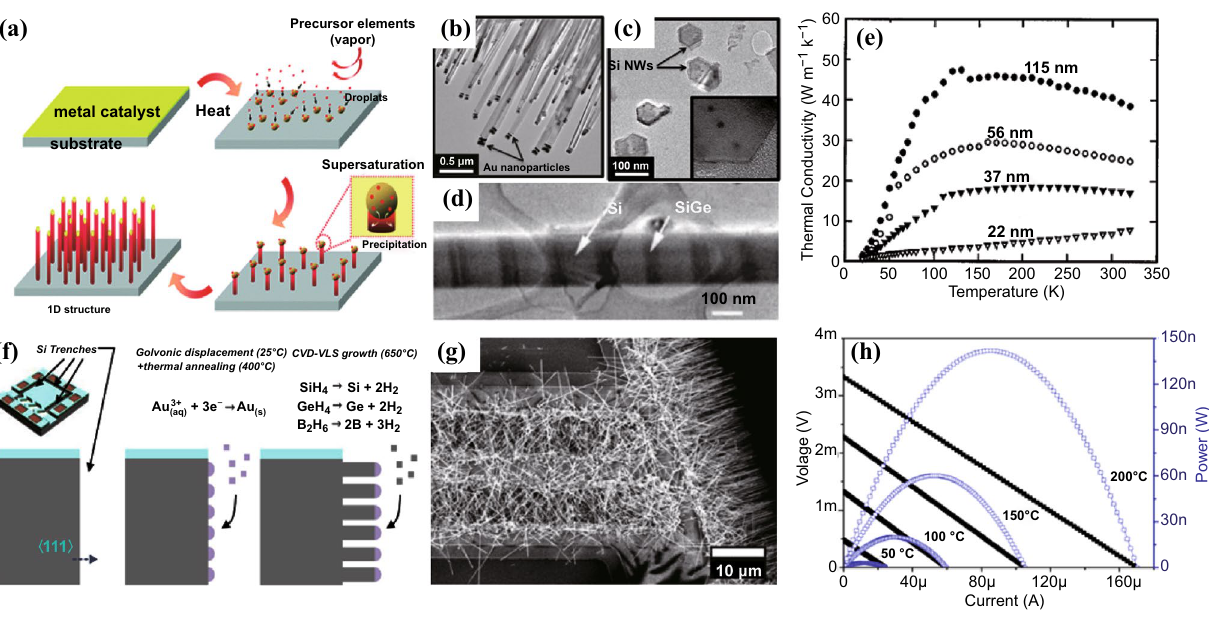
Fig. 9 a Schematic diagram of the synthesis of the NWs by VLS growth method. b TEM image of Si NW arrays showing gold nanoparticles on the tip. c Cross-section TEM image of silicon NWs showing hexagonal shape. d TEM image of Si/SiGe superlattice NWs. e Measured thermal conductivity of different diameter Si NWs. f Schematic steps for CVD-VLS growth of boron-doped SiGe NWs and integration in μTEGs. g Top- view SEM image of SiGe NWs selectively grown in Si exposed parts. h Current–voltage and current-power curves obtained from SiGe NWs based μTEGs with three trenches for different hot plate temperatures. Adapted with permission from Refs.